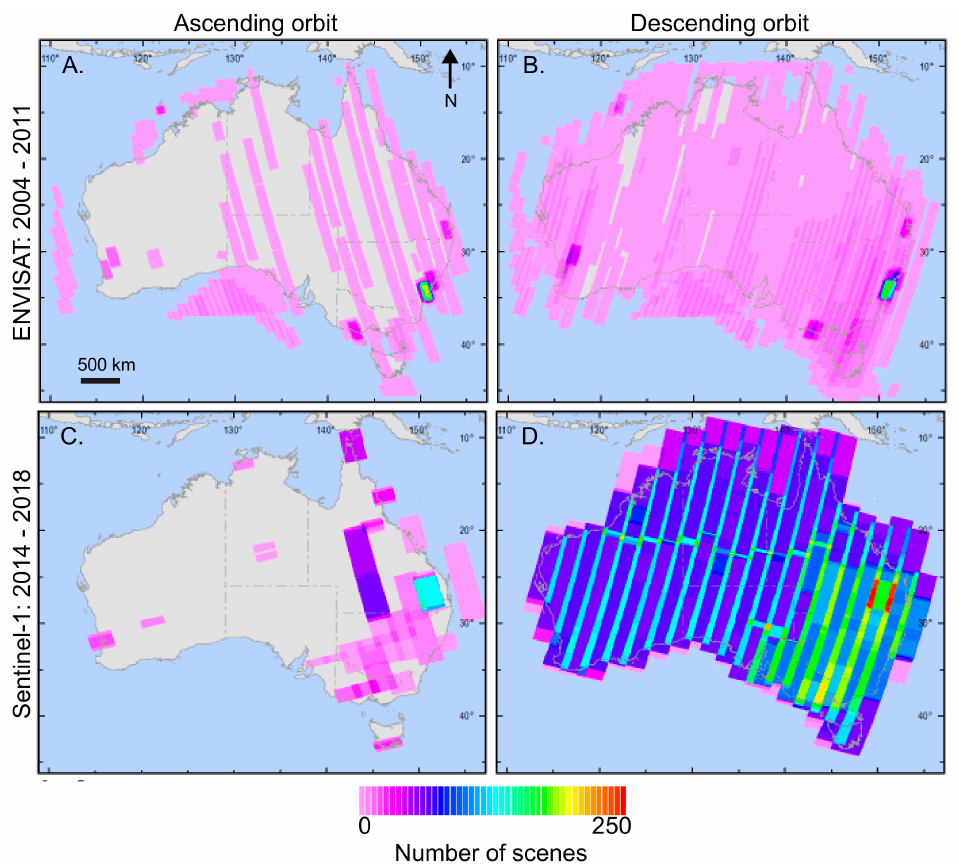
Figure 1. Expansion in the availability of open-access Synthetic Aperture Radar (SAR) imagery over Australia. Demonstrated by a comparison between ( A , B ) the past European Space Agency sensor ENVISAT ASAR (2004–2011) and ( C , D ) the current European Space Agency constellation Sentinel-1 (2014–present), with the number of scenes calculated as of July 2018. Sensor specifications can be found in Table S2, Supplementary